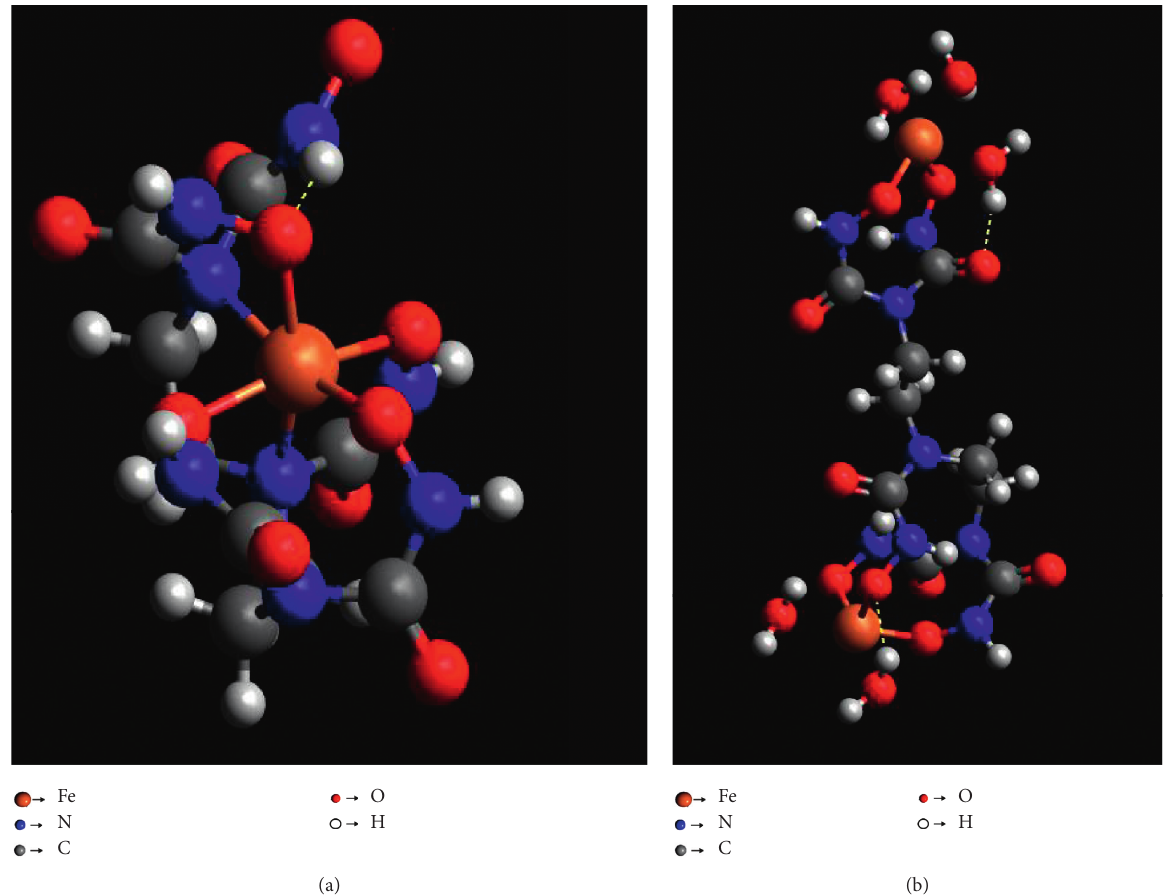
Figure 6: BOEN complexed with (a) one Fe 2+ and (b) two Fe 2+ ions showing the intrahydrogen bonding in broken yellow lines.